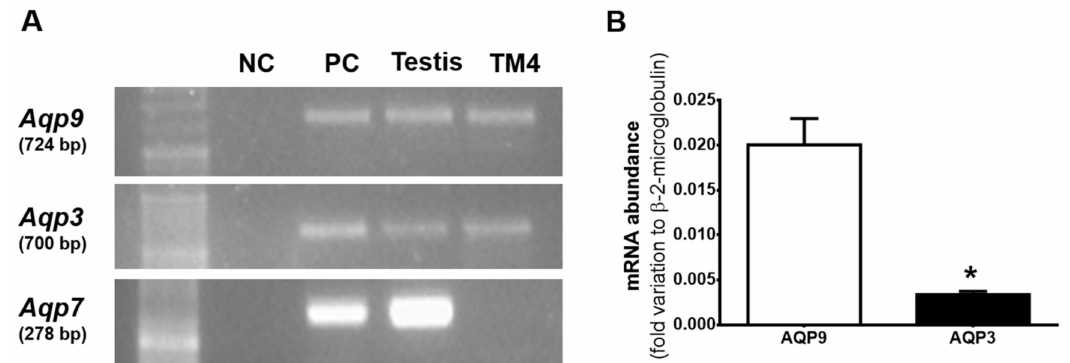
Figure 1. Identification and quantification of mRNA abundance of Aquaporin-3 ( Aqp3 ), Aqp7 , and Aqp9 in mouse testis and mouse Sertoli cells (mSCs). ( A ) representative reverse transcriptase-PCR